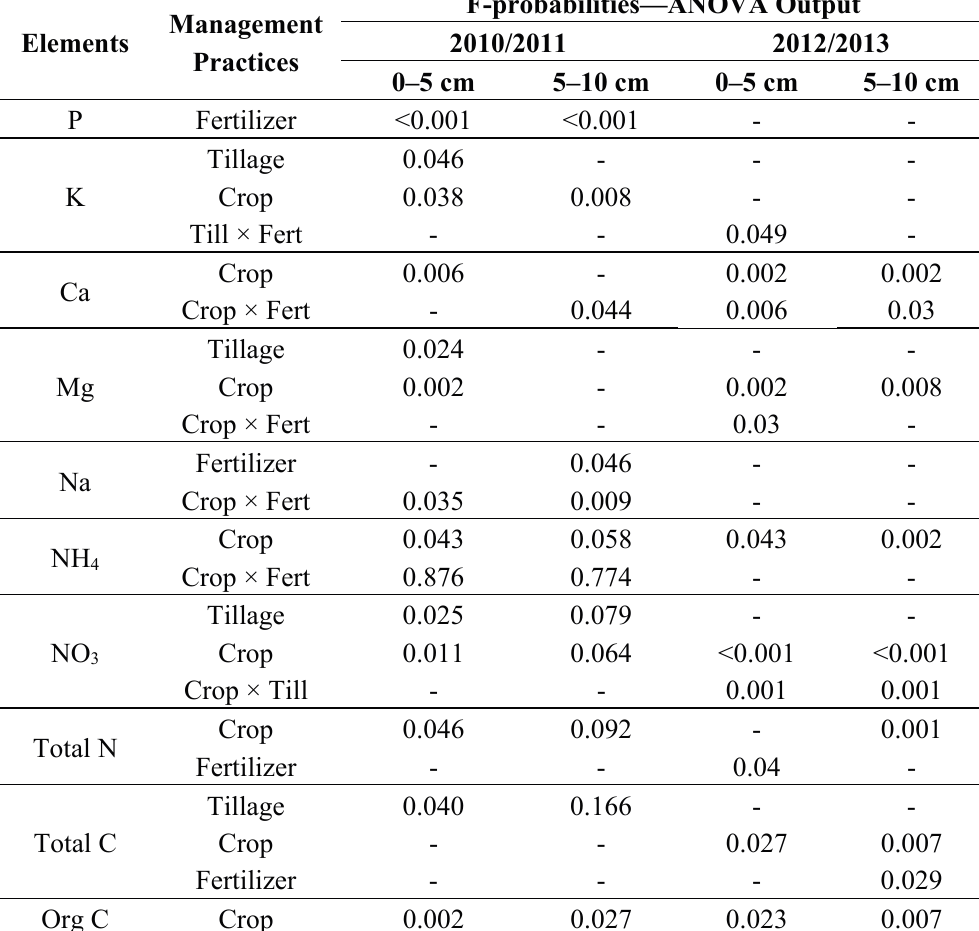
Table A2. F-probabilities indicating significant changes in selected top-soil elements as a result of different management practices for the year 2010/2011 and 2012/2013.